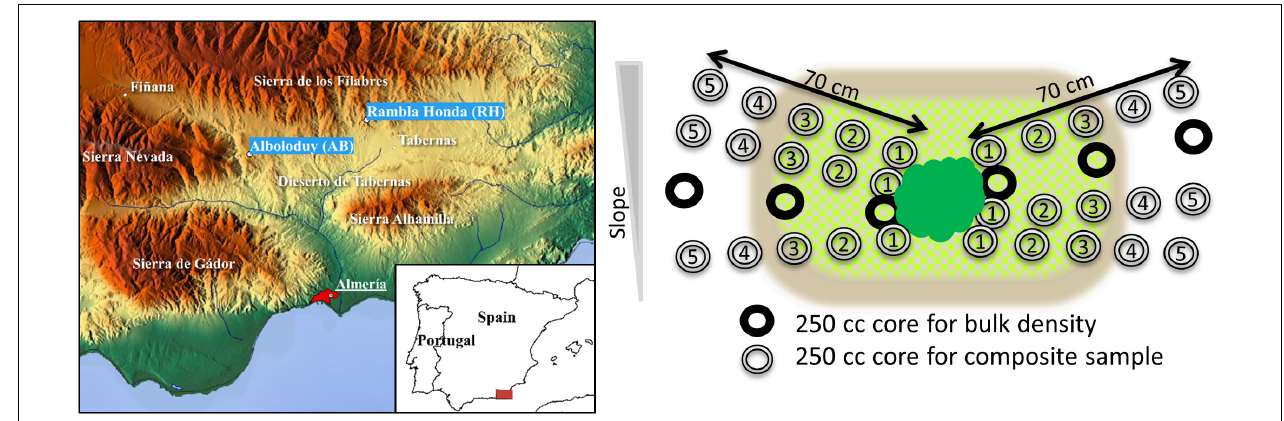
FIGURE 1 | Location of the study area, sample sites Alboloduy and Rambla Honda and the weather stations Finana and Tabernas (left). Sampling design, i.e., butterfly approach, whereby 250 cm 3 cores were placed as close as possible to the stem (dark green) and cores with the same numbers were combined in a composite sample. Numbers stand for the distance from the center of the core to the stem, i.e., 4 (1), 19.5 (2), 35 (3), 50.5 (4), and 66 (5) cm. Average canopy diameter is indicated with light green (blocked pattern) for Anthyllis and brown for Macrochloa . TABLE 1 | Mean and standard deviation of the soil properties of the two studied sites ( n = 5). Unit Rambla Honda